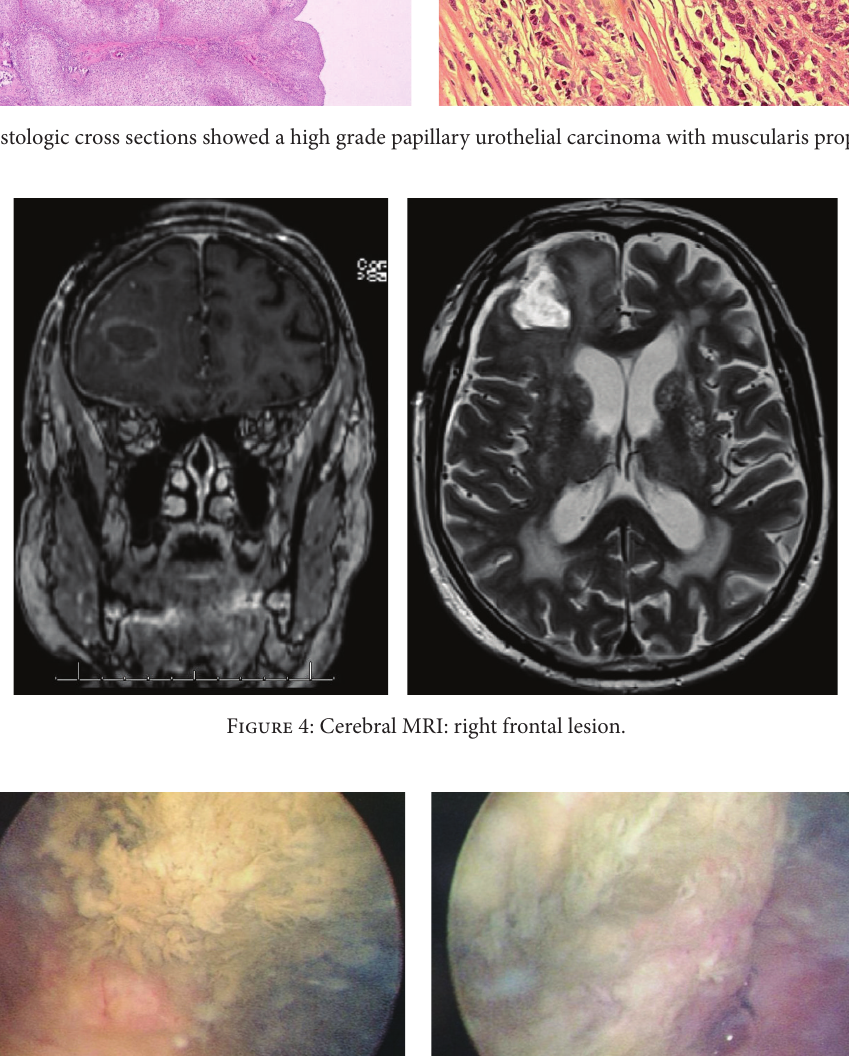
the ability to seed and implant, even on nonurothelial surfaces